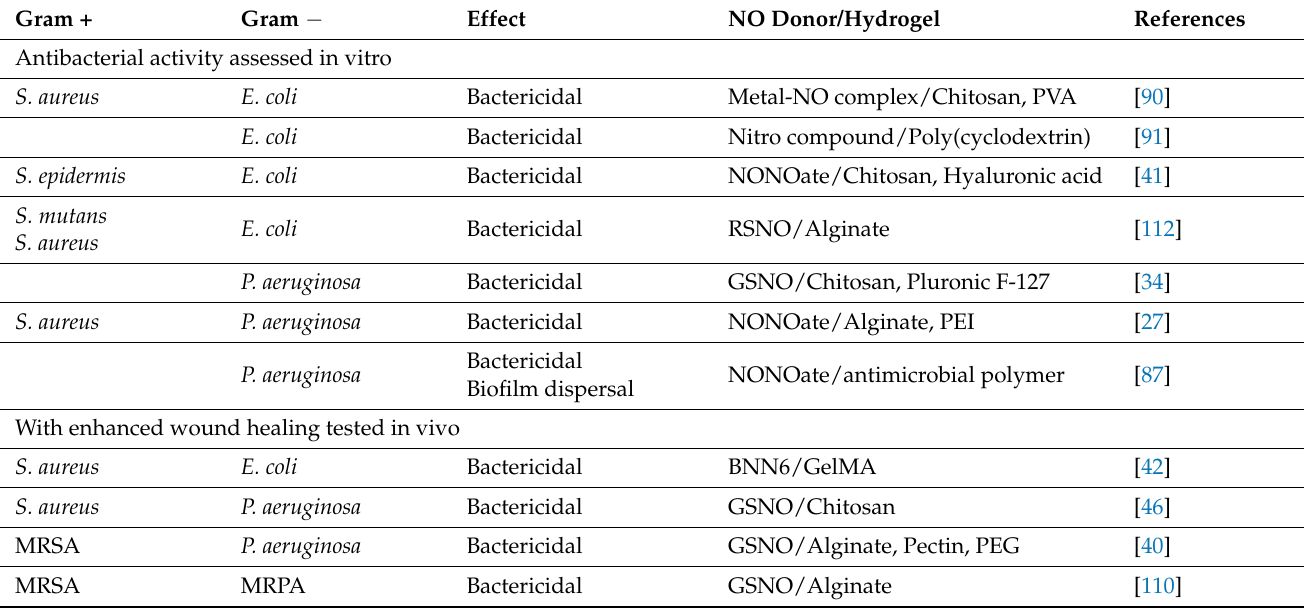
Table 6. Antibacterial activity of NO-releasing hydrogels against Gram-positive and Gram-negative bacteria, with a focus on the systems with enhanced wound healing tested in vivo.